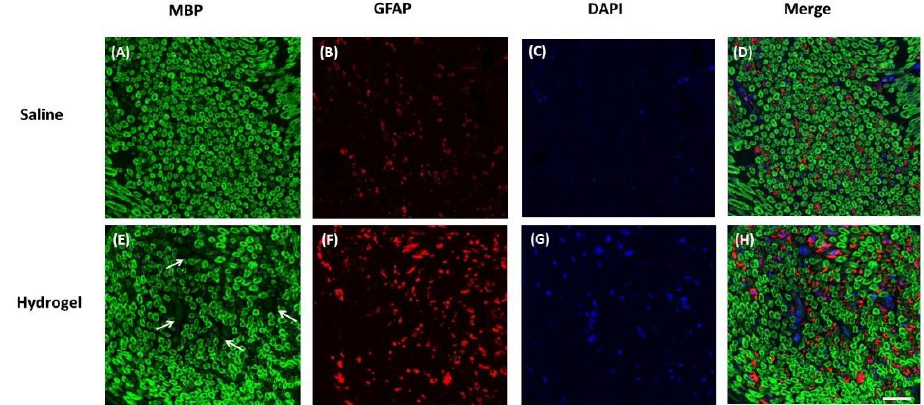
Figure 5. Representative micrographs of triple immunohistochemical staining of sciatic nerve, short-axis view 14 days after the injection of normal saline ( A – D ) and hydrogel ( E – H ). In the hydrogel group, the myelin basic protein (MBP) showed patchy areas (arrows) of breakdown ( E ), and glial fibrillary acidic protein (GFAP) showed increased expression ( F ). 4′,6-Diamidino-2-Phenylindole, Dihydrochloride (DAPI) was used for nucleic acid staining (scale bar: 40 μm).